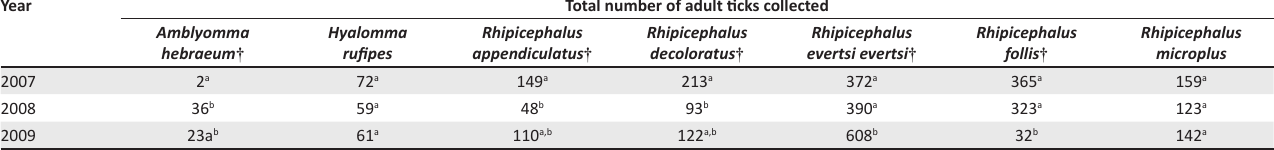
TABLE 4: Number of adult ticks collected during each 12-month period from six Bonsmara cattle and three Nguni cattle (February 2007 to January 2010). Total number of adult ticks collected